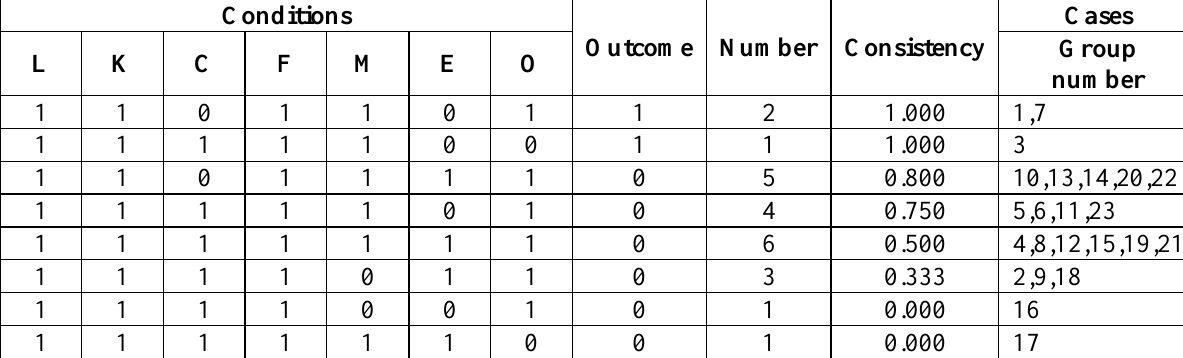
Appendix 2. Truth table of crisp-set qualitative comparative analysis (csQCA) at the group level using the percentage of the maximum earning as the indicator of group performance.